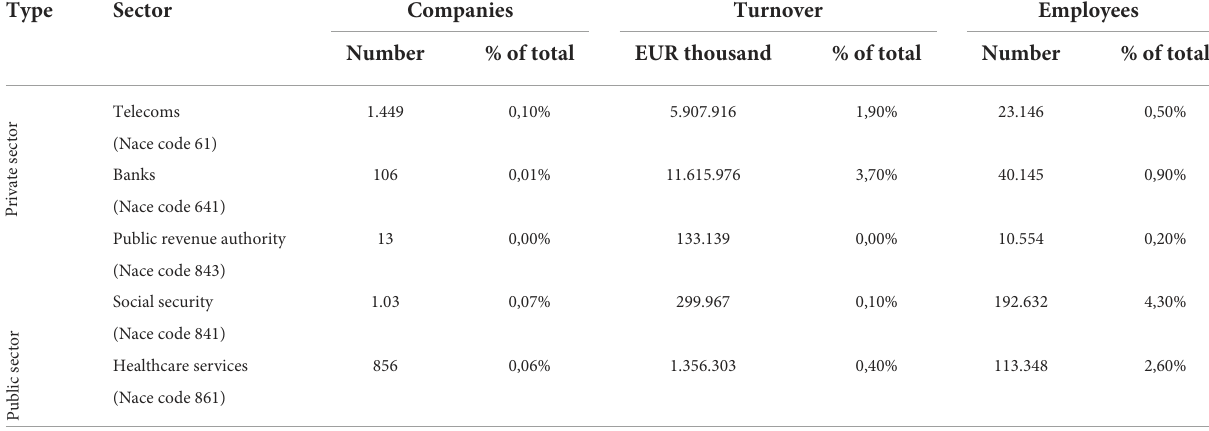
TABLE 2 Sectors’ contribution to employment and production, 2019.